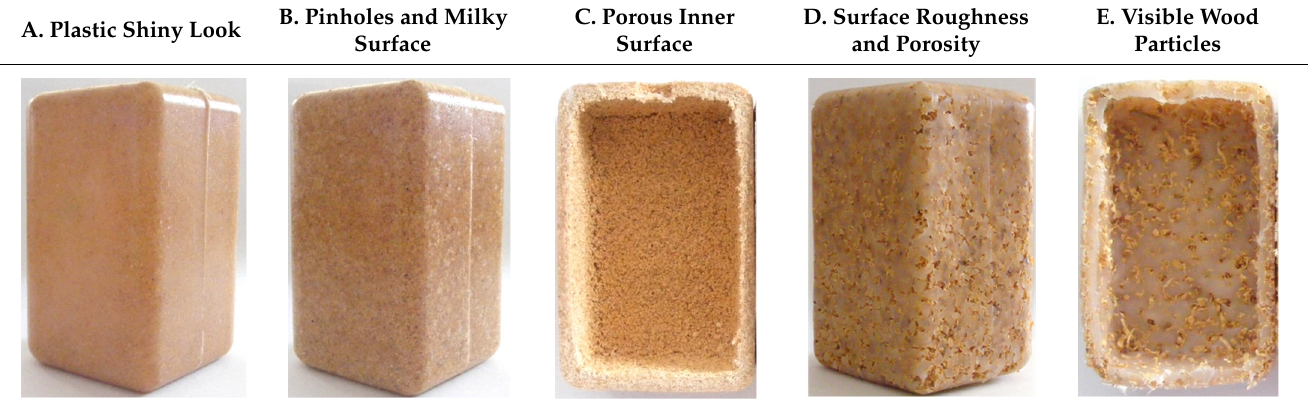
Table 5. Images of parts produced by MDPE/wood composites with 10, 15, 20, 25 and 30% wood